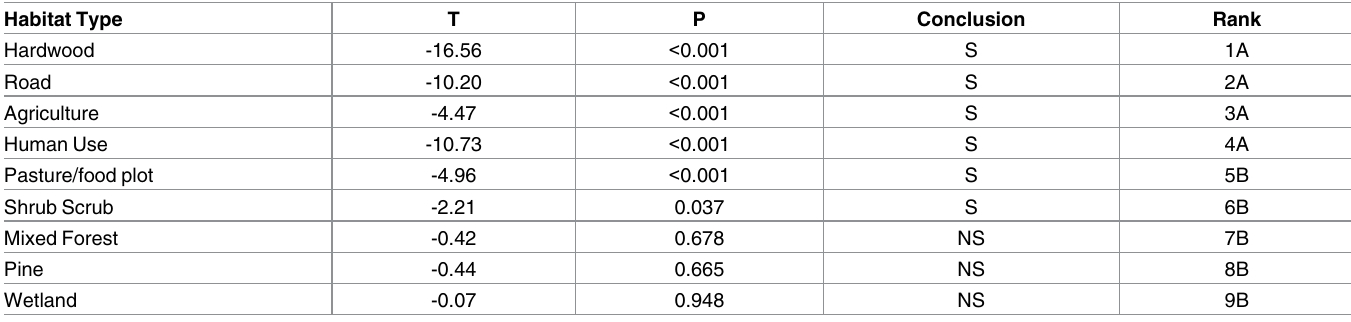
Table 2. Habitat types ranked in order of preference(1 most preferred-9 least preferred) for selection of diurnal refugia by gray foxes from 2014– 2015 on the Joseph W. Jones Ecological ResearchCenter at Ichauway, and surrounding lands in Baker County, Georgia, USA. Significantdiffer- ences ( P < 0.05) amongranks are indicatedby different letters. S = Selected, NS = Not Selected(used as